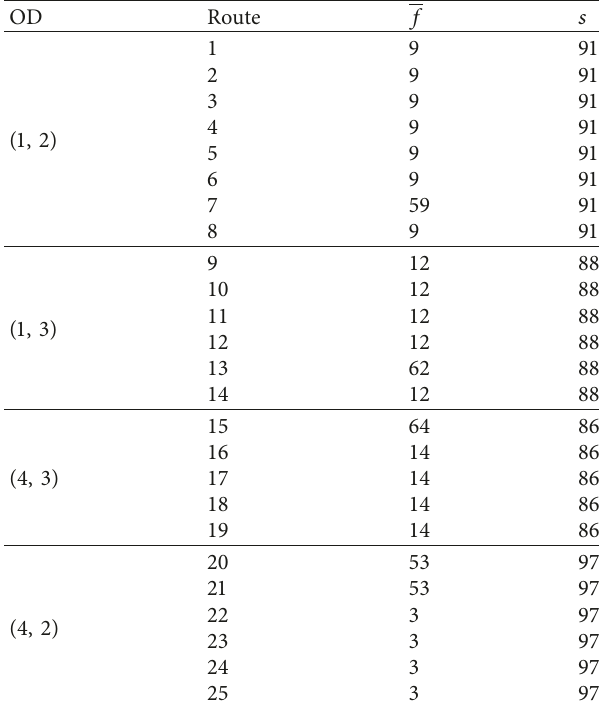
Figure 9: Evolutionary trajectories of route flows (a) and route travel costs (b) for travellers in the first group. Table 11: Route flow and surplus capacity in mixed equilibrium for travellers in the second